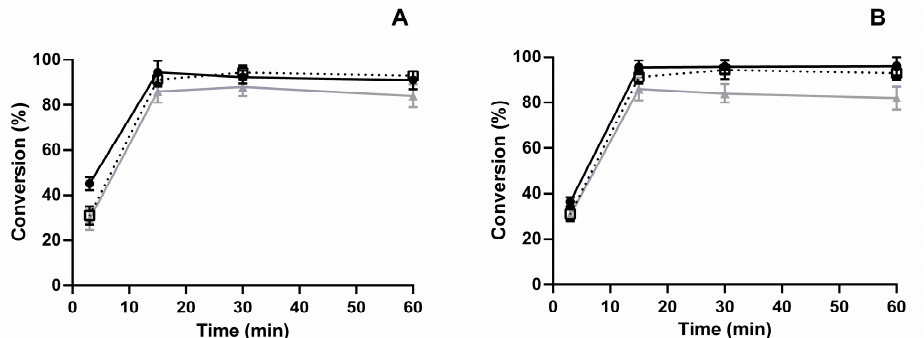
Figure 3. Study of several parameters using SiG PEI25000 - Ld NDT derivative for cladribine biosynthesis. ( A ) Effect of pH on reaction time course, ( (cid:0) ) 25 mM sodium acetate buffer, pH 5.0; ( • ) 25 mM tris-HCl buffer, pH 7.0; ( ▲ ) 25 mM tris-HCl buffer, pH 9.0. ( B ) Effect of temperature on reaction time course, ( • ) 30 °C, ( (cid:0) ) 50 °C, and ( ▲ ) 60 °C.